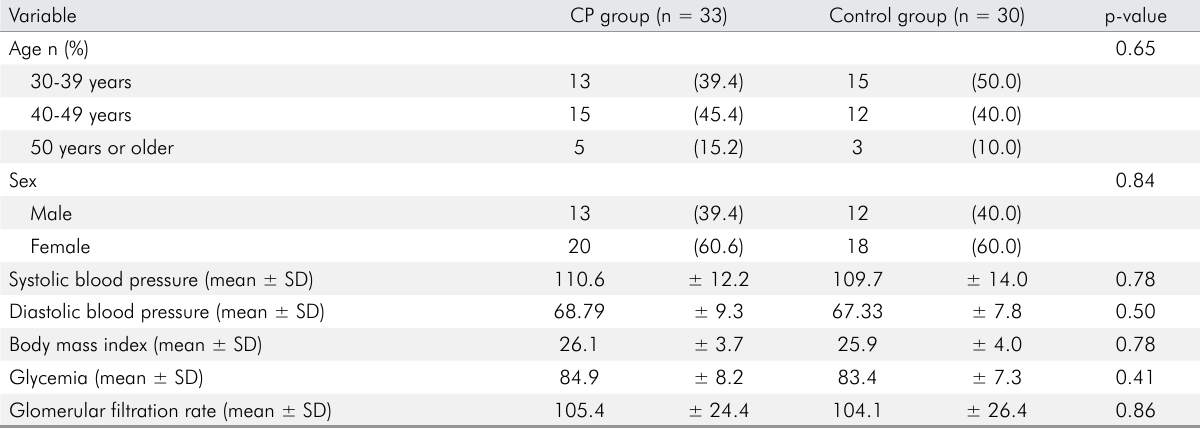
Table 1. Distribution of general and medical characteristics of the sample.